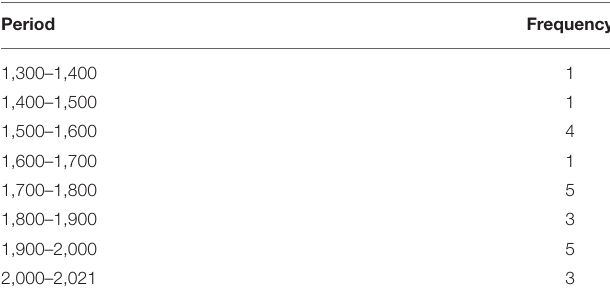
TABLE 1 | Pandemics frequency since the middle ages. Period